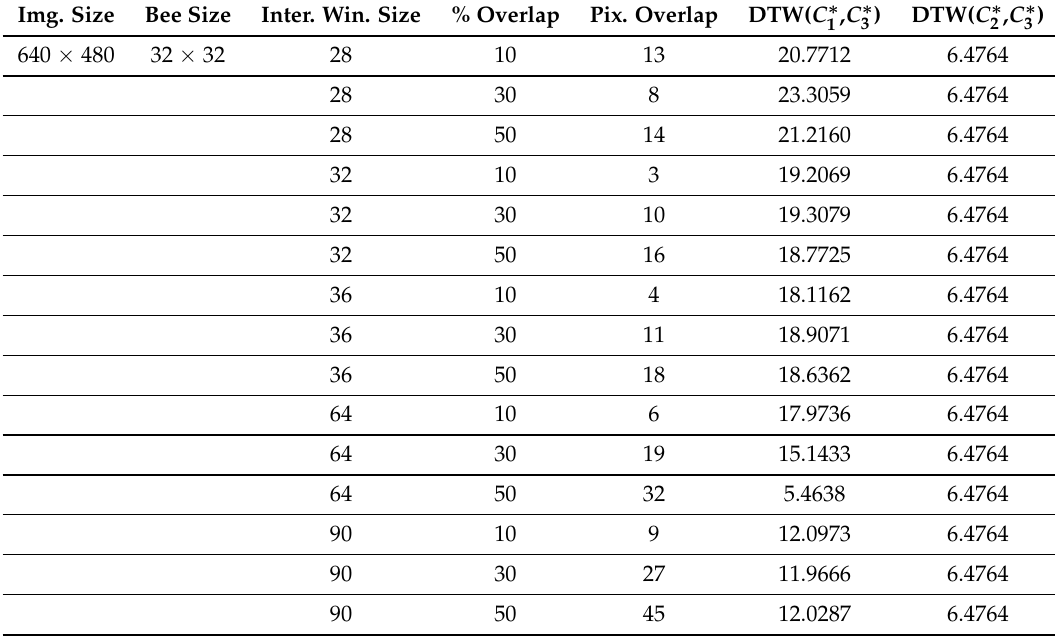
Table A7. DTW values for NT _ Vid . mp 4 with image size of 640 × 480; C ∗ and C ∗ is Human Count (ground truth). 3